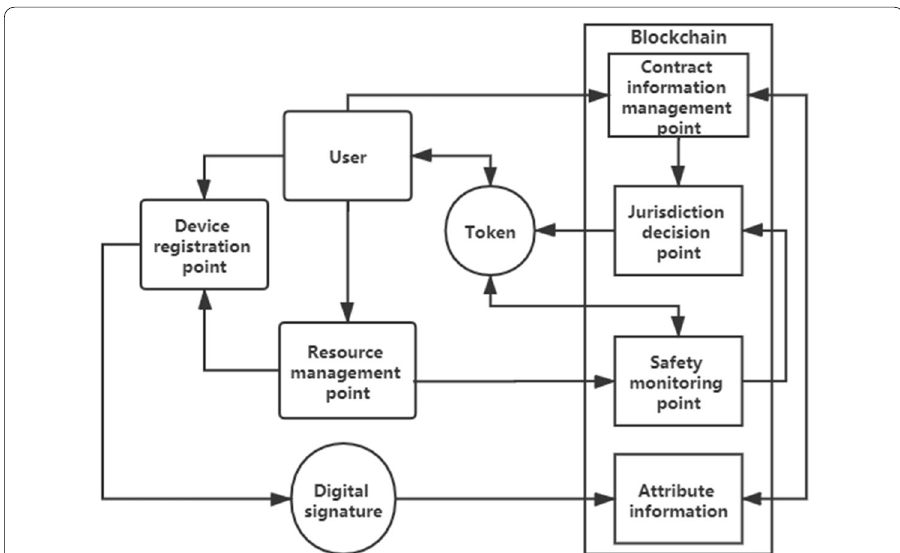
Fig. 1 Access control model. The resource owner publishes the unique identifier and object property information of the device on the blockchain as the basis of fine-grained access control authority decision, stores it through a smart contract, and records the address of the property owner. When a user needs to authenticate the device’s attribute information to access a private resource, the identity can be retrieved